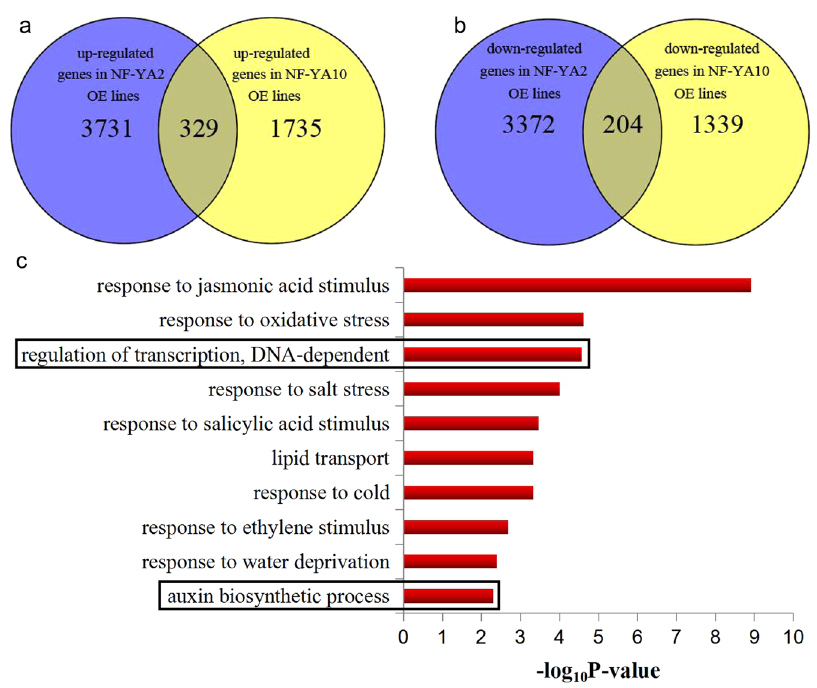
Figure 5. Up ( a ) and down ( b ) DEGs between NF-YA2 OE plant and NF-YA10 OE were analyzed using VENN and significantly enriched Gene Ontology (GO) categories with the common DEGs ( c